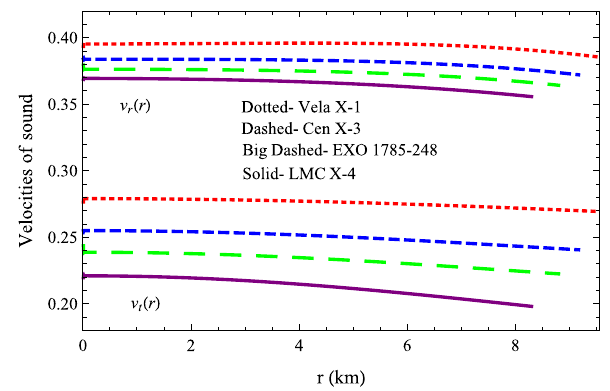
Table 2 for four well-known compact